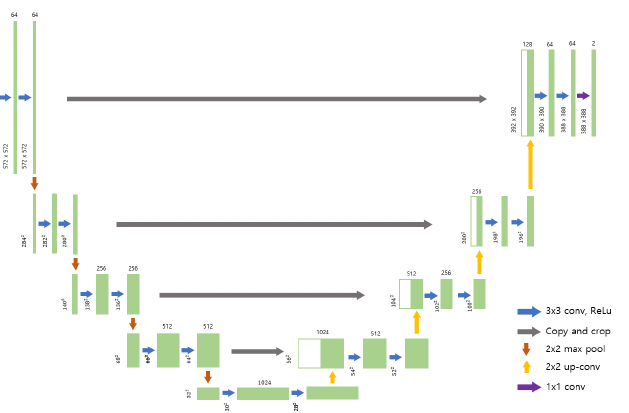
Figure 2. UNet architecture. As shown in this figure, the U-shaped model which is used especially for segmenting medical images